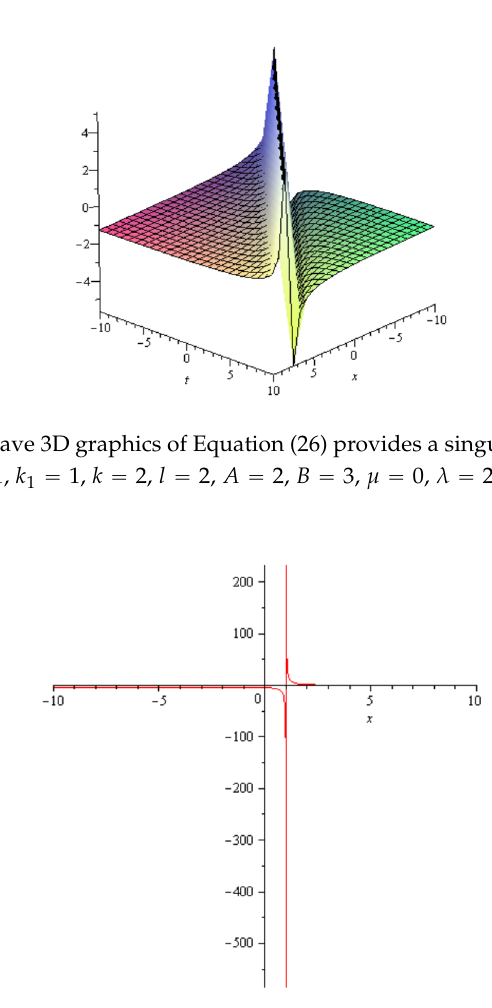
Figure 4. The solitary wave 2D graphics of Equation (25) provides a periodic solution profile for,